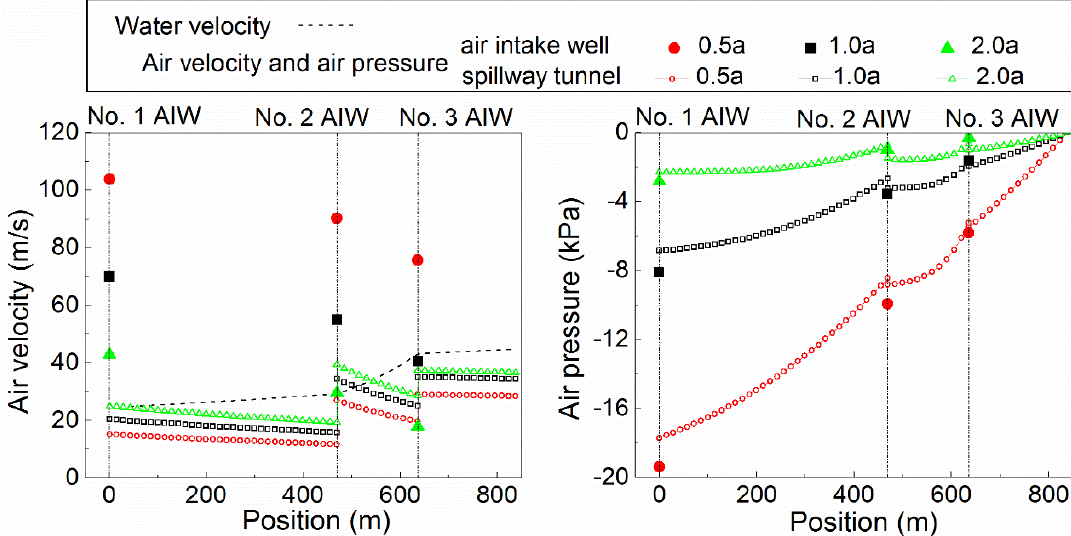
Figure 12. Influence of the cross-sectional area of the air intake wells on the ventilation characteristics.